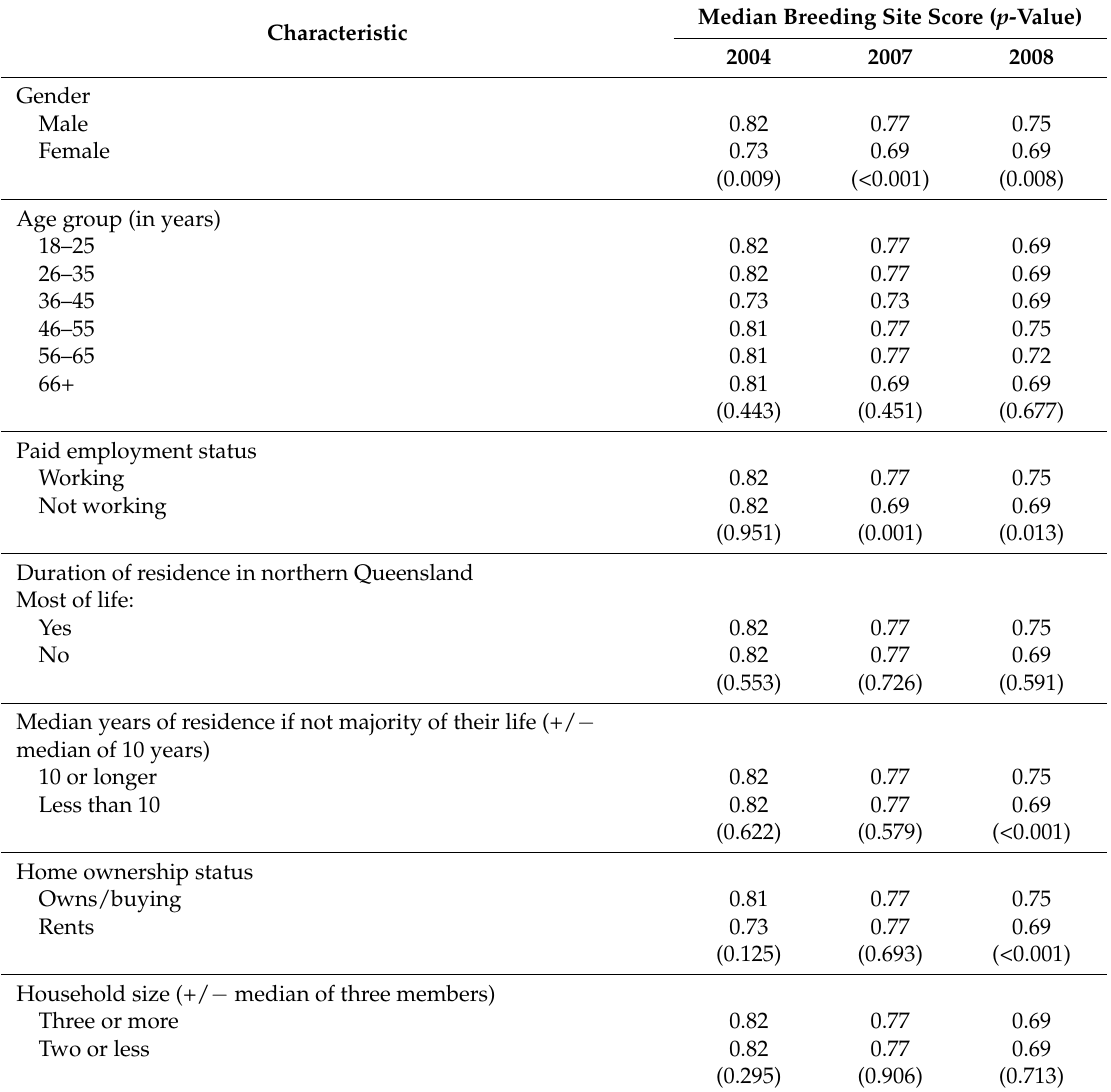
Table 2. Bivariate associations with median breeding site scores in northern Queensland—2004, 2007, and